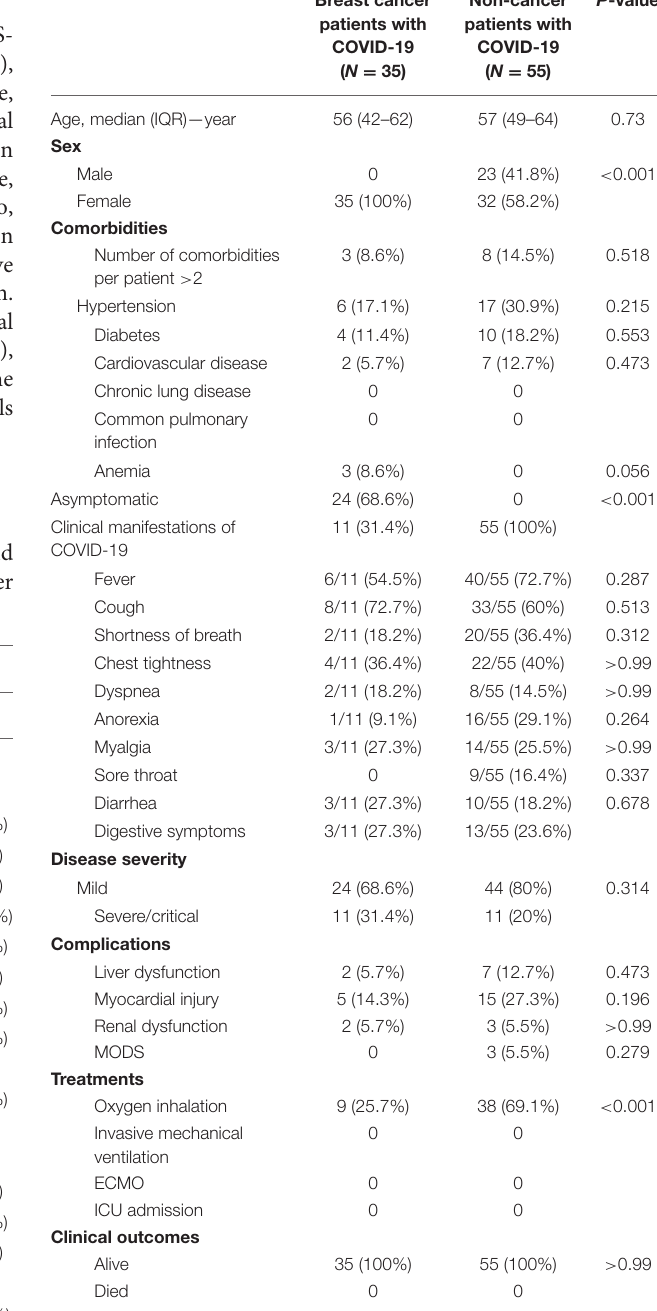
TABLE 5 | Comparison of clinical characteristics and outcomes between breast cancer patients with COVID-19 and non-cancer patients with COVID-19. Breast cancer patients